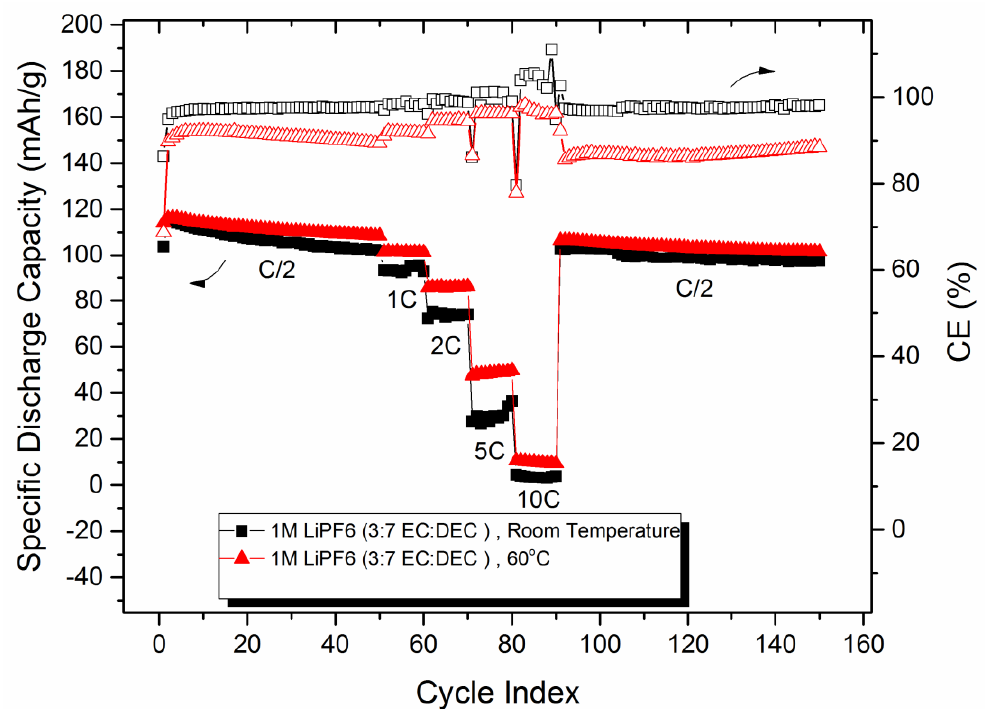
Figure 9. C-rate testing of LMNTO at room temperature and 60 °C.